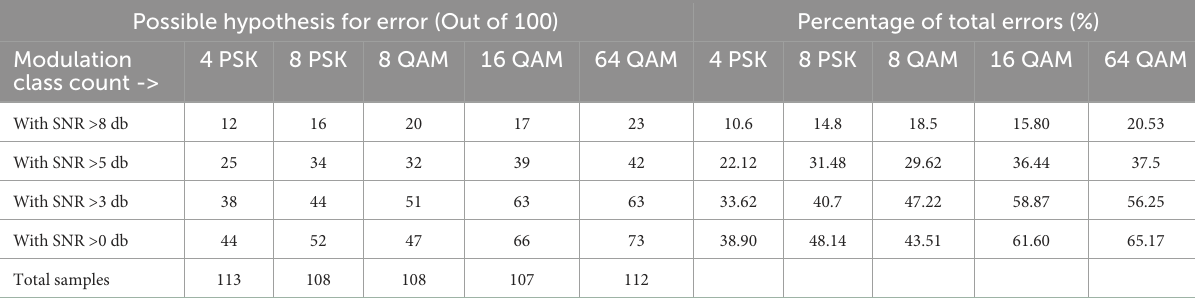
TABLE 1 Error-Analysis for our CNN-based Automatic Modulation Classifier